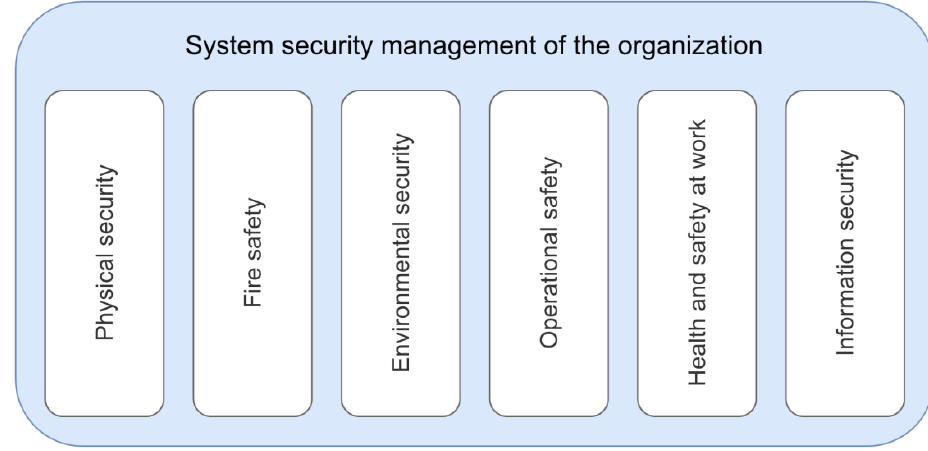
Figure 2. Security pillars of the organization [36].